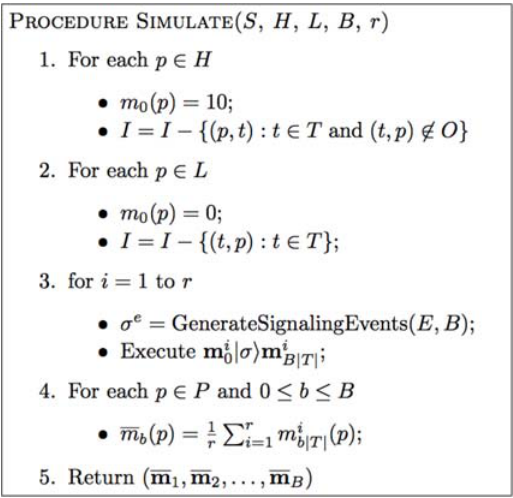
Figure 7. The Procedure for Simulating a Signaling Petri Net. S IMULATE predicts the signal flow through the SPN S. The simulation is run for B time blocks; the results of r runs are averaged to produce the final result. Most of the work is done by the signaling Petri net execution procedure detailed in the preceding sections. This execution actually performs an individual run. This procedure takes the initial marking, m 0 , and applies the sequence of transitions triggered by the event sequence, s e . This ordering, generated by the algorithm in Figure 6, has the dual time structure in which each block of edges contains every event in E exactly once. Each firing evaluates the effect of one transition. The markings at the end of each time block are extracted in Step